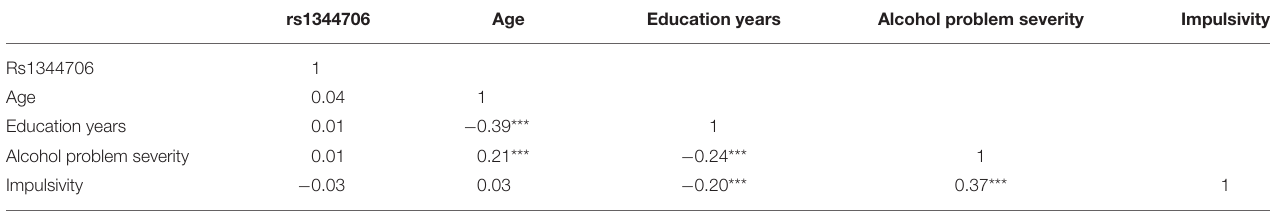
TABLE 3 | Descriptive statistics and correlations among study variables.